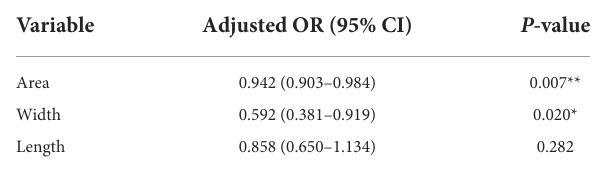
TABLE 3 Odds ratios from logistic regression, adjusted for age and